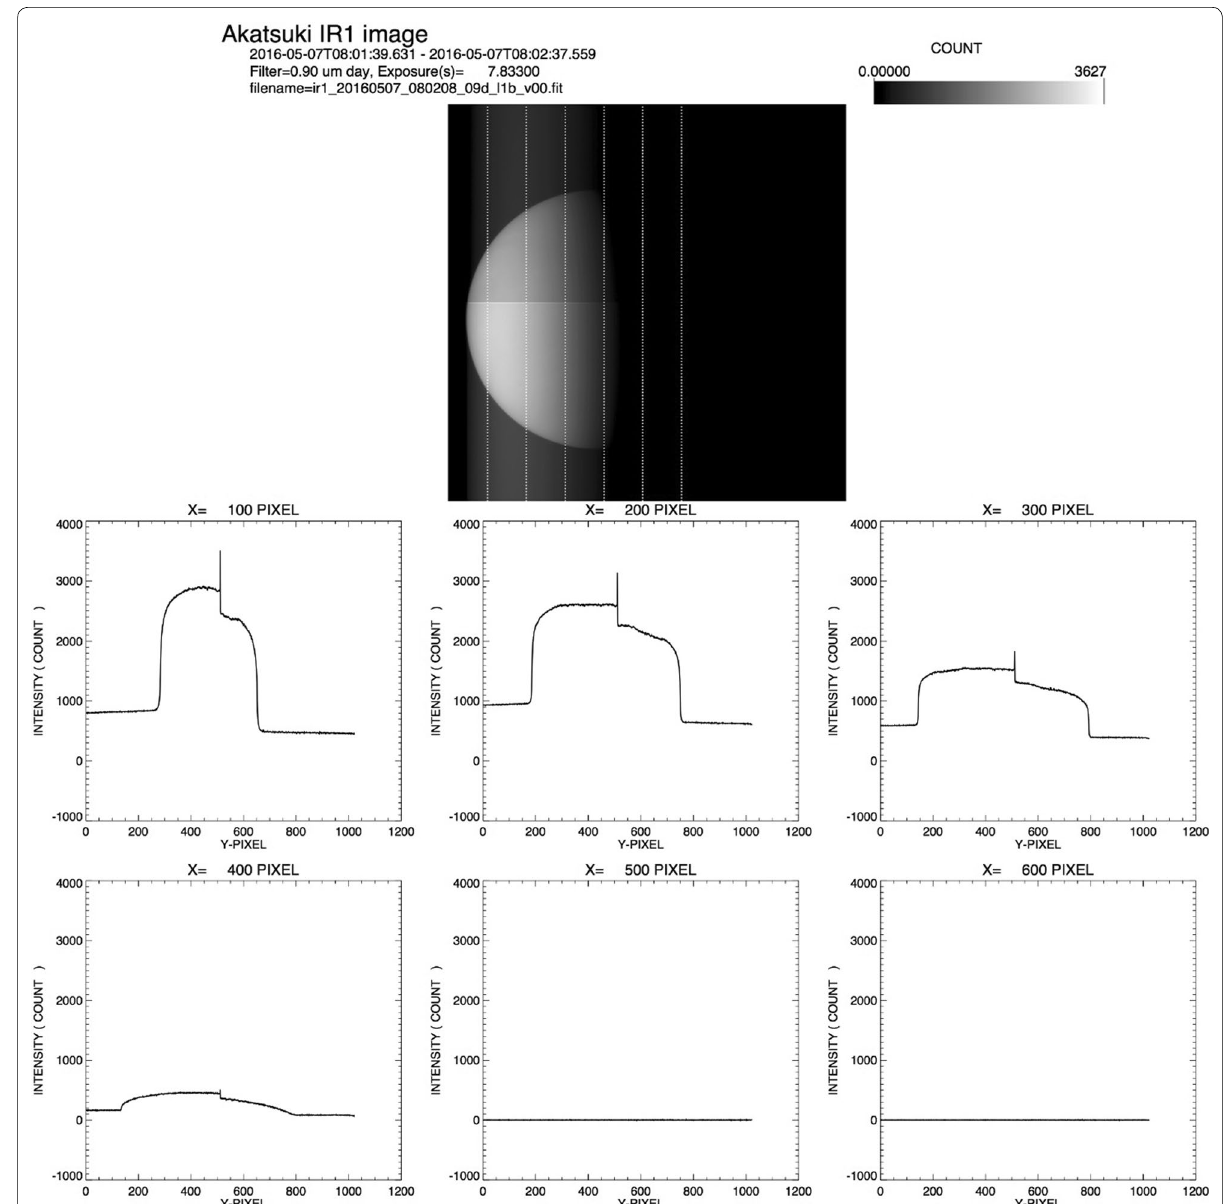
Fig. 5 Vertical cross sections of the Level 1 image before correction shown in Fig. 4a. The smear‑like noise is seen on the left side. The six panels on the bottom show intensity along the vertical dotted line (at x 100–600) in the top image. The date and time are found in the top =